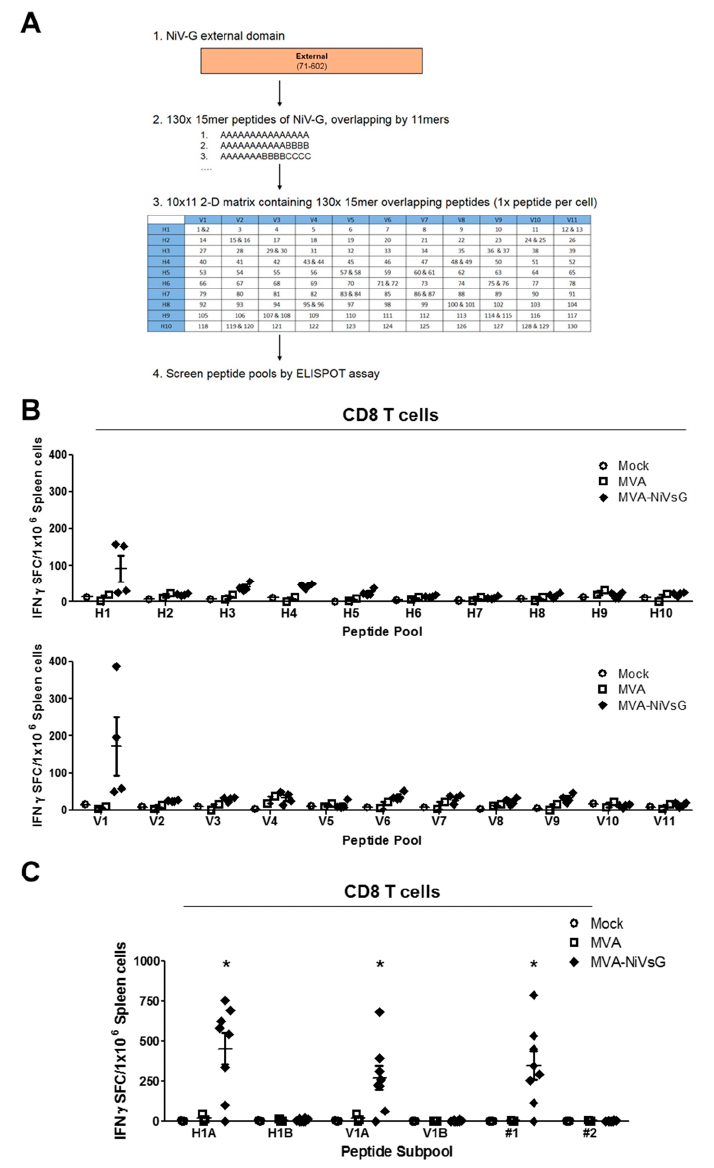
Figure 3. Screening for H2-b-restricted T cell epitopes of NiV-G protein. IFNAR − / − mice were immunized twice with 10 8 PFU of MVA–NiVsG via the intraperitoneal (i.p.) route over a 21 day period (2–5 per group). Mice inoculated with nonrecombinant MVA (MVA) or saline (mock) were used as controls. Eight days after the booster immunization, spleens were collected and single cell suspensions were prepared. CD8 T cells were purified by magnetic bead selection and restimulated with pools of 10–13 overlapping 15mer peptides of NiV-G or subpools of positive peptide pools and analyzed by IFN- γ ELISPOT assay. ( A ) Schematic overview of peptide mapping strategy. A peptide library was generated comprising of 15mer peptides (overlapping by 11mer) that spanned the external domain of the wild-type NiV-G protein. Peptides were organized into a two-dimensional matrix of peptide pools (horizontal rows (H)1–(H)10 and vertical rows (V)1–(V)11) containing 11–13 peptides. Each cell of the matrix represents an individual 15mer peptide. ( B ) Screening for H2-b-restricted T cell epitopes of NiV-G in CD8 T cell enriched splenocytes measured by ELISPOT assay. Graphs shows IFN- γ spot-forming cells (IFN- γ SFC) of CD8 T cells stimulated with peptide pools. ( C ) Screening of subpools of positive peptide pools H1 (H1A and H1B) and V1 (V1A and V1B) and individual 15mer peptides shared between the two pools, #1 (YTRSTDNQAVIKDAL) and #2 (TDNQAVIKDALQGIQ). Graphs shows IFN- γ SFC (spot-forming counts) of stimulated CD8 T cells. Di ff erences between groups were analyzed by one-way ANOVA. Asterisks represent statistically significant overall di ff erences for a specific peptide subpool or individual peptide. * p <